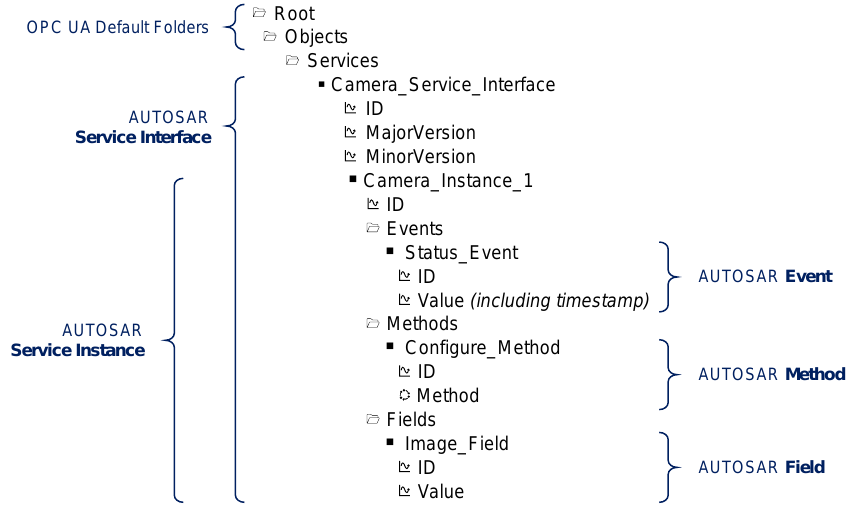
Figure 11. Representation of an AUTOSAR service instance in the OPC UA information